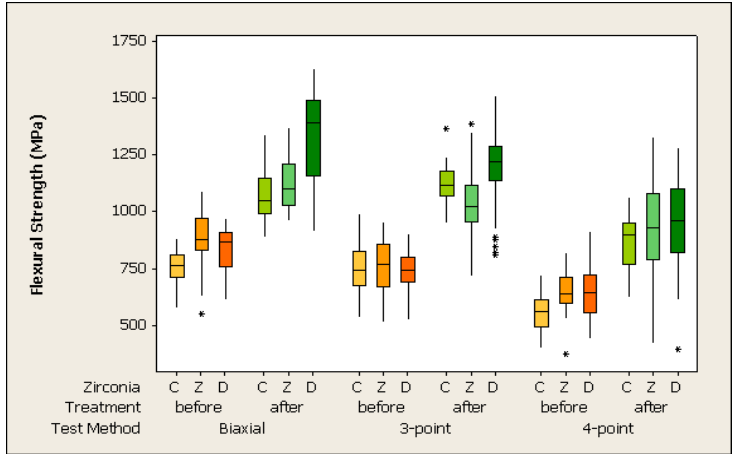
Figure 2. Influence of specimen preparation test method and zirconia material using different flexural strength testing methods.